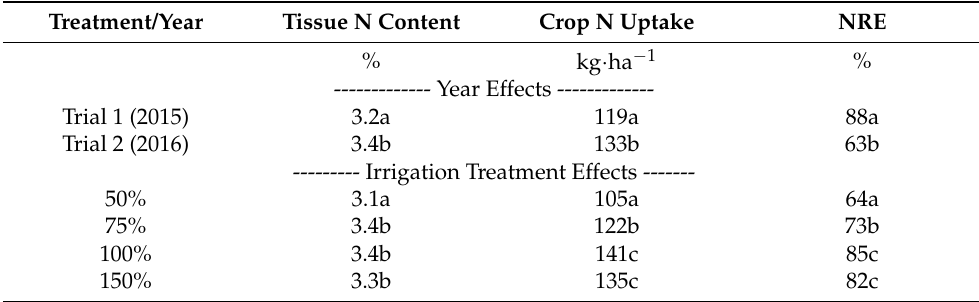
Table 4. Average tissue N content, aboveground crop N uptake, and nitrogen recovery efficiency of irrigation for both trials (data pooled across treatments) and of irrigation treatments (data pooled for both trials). Treatments are 50–150% of crop water requirement. Means with different letters are statistically different at the p < 0.05 confidence